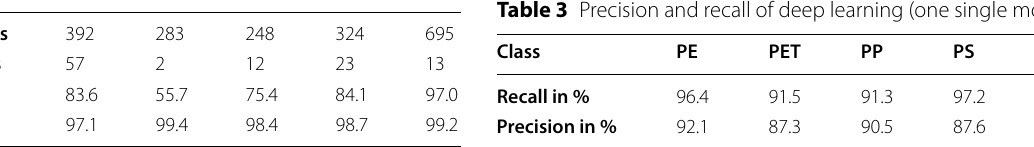
Table 2 Errors, precision, and recall of the first human annotation in comparison to the second human annotation (ground truth) Class